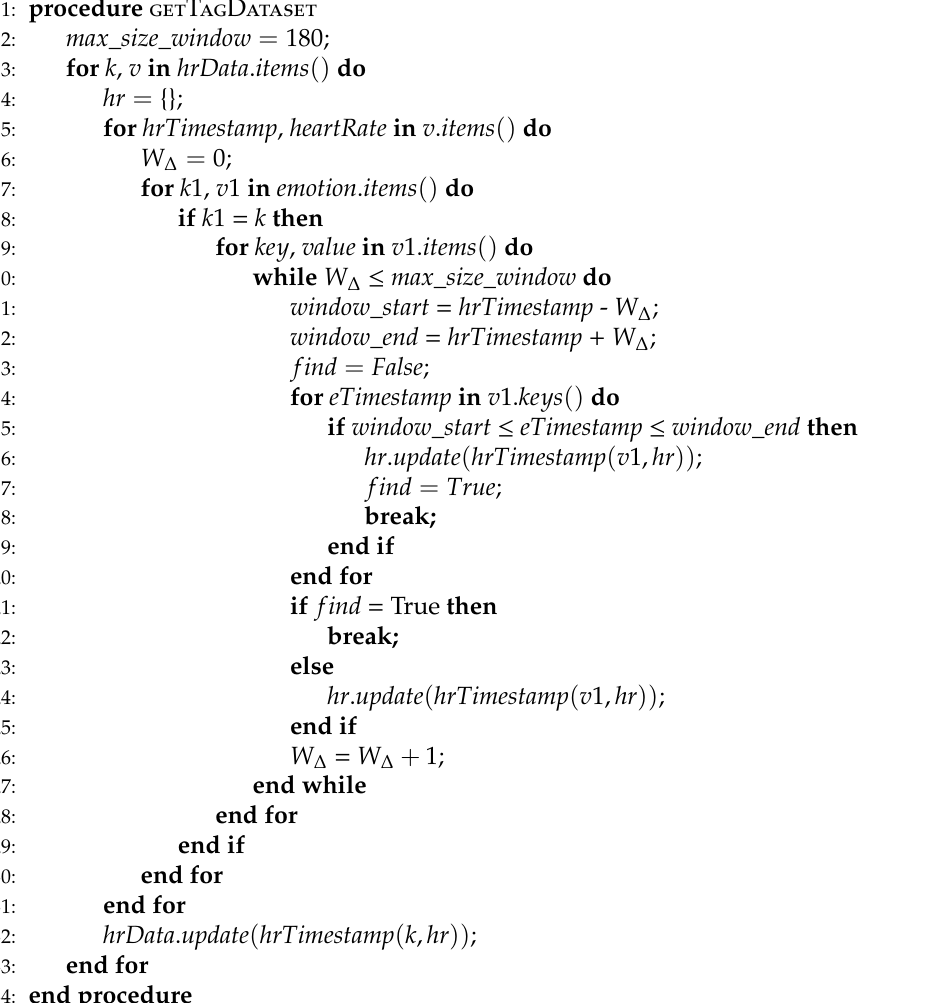
Algorithm 1. Sliding and adjustable window for the time series data